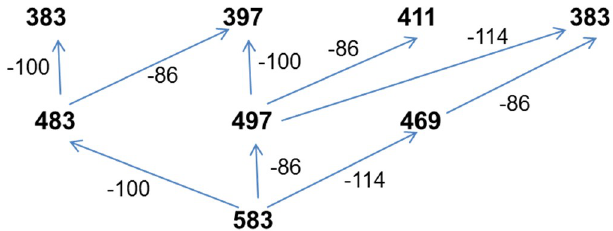
Scheme 2. Proposed fragmentation paths of the parent ion m/z 583 observed in the ESI-MS/MS spectrum.